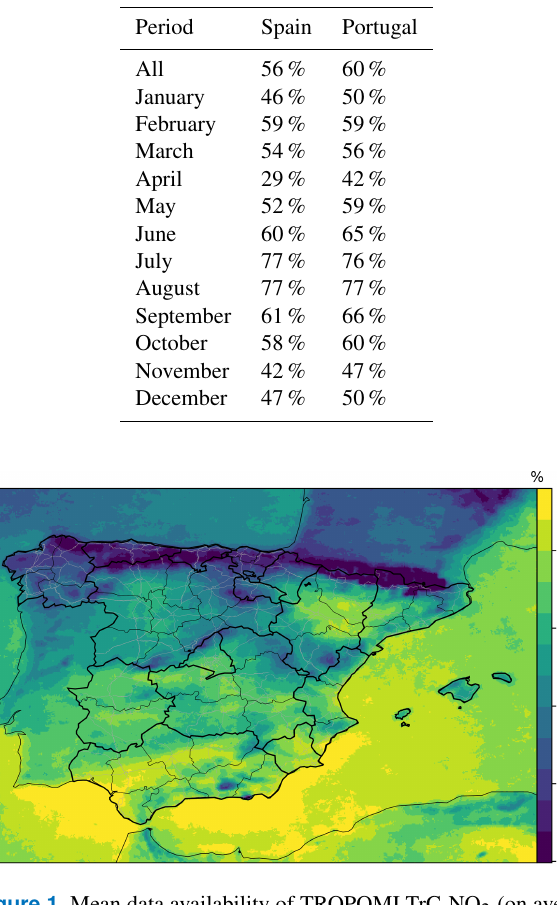
Figure 1. Mean data availability of TROPOMI TrC-NO 2 (on aver- age from May 2018 to December 2021). Black and grey lines cor- respond to administrative borders and Spanish major roads, respec- tively (sources: see Sect.